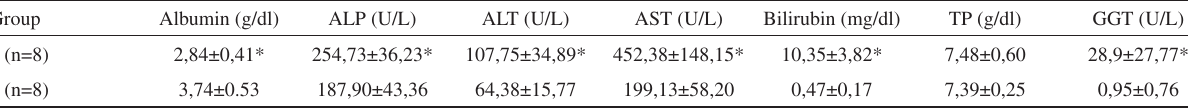
Table 1 - Mean values of the serum biochemical analysis